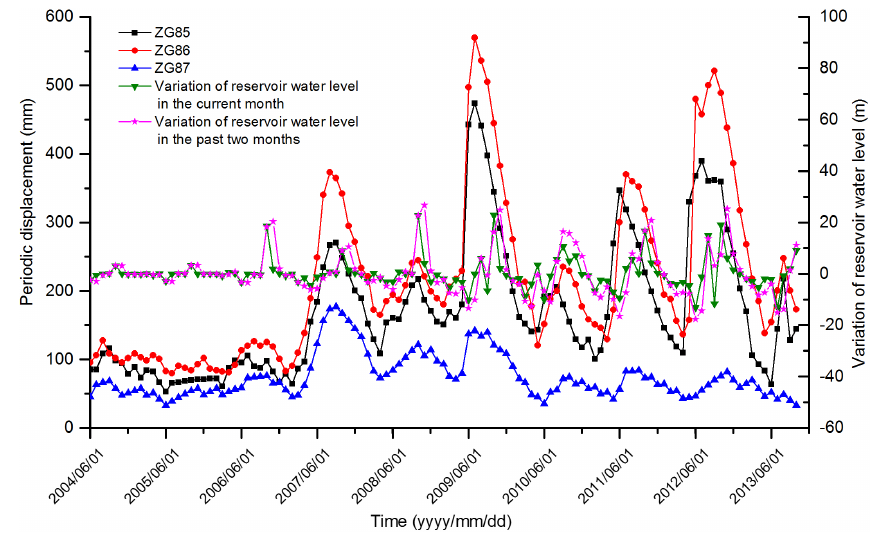
Figure 10. The relationship between reservoir water level and the periodic displacement at GPS monitoring stations.